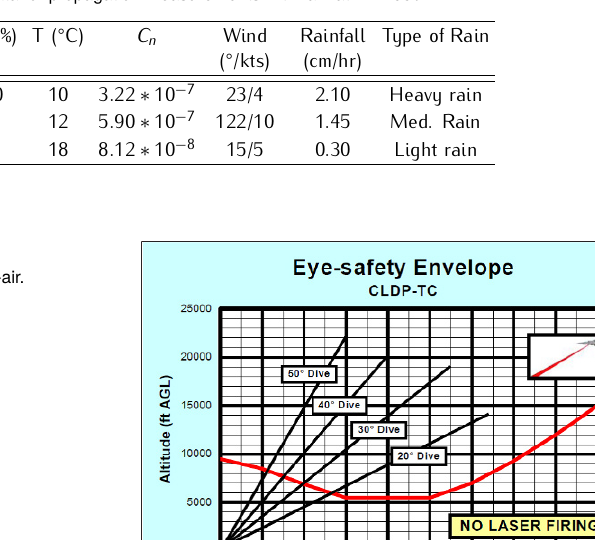
Table 16. Meteorological data for propagation measurements with rain at λ = 1550 nm.